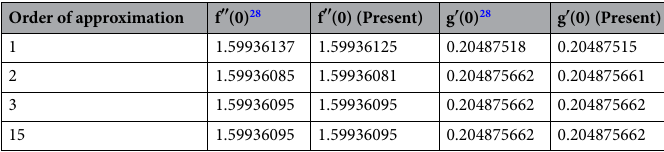
Table 1. Comparison of the current